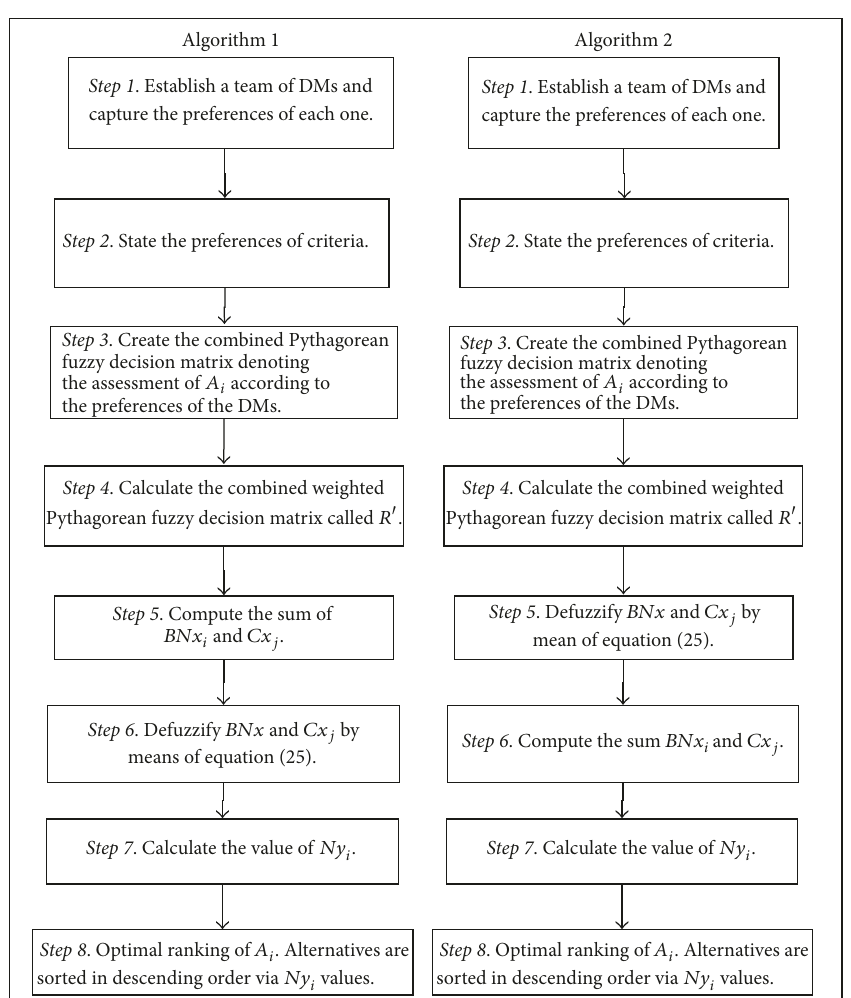
Figure 1: Flowcharts of the algorithms of the PF-MOORA